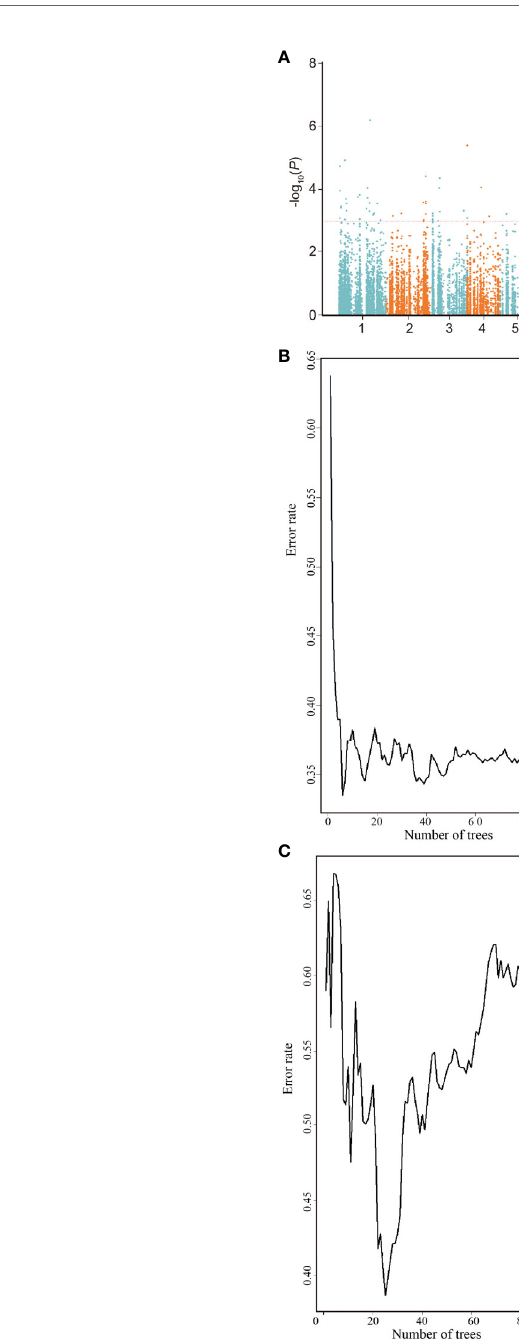
FIGURE 2 | Identi fi cation of an ATIRE prognostic signature for OS and DFS of BRCA patients. (A) Scatter plot of p -values in − log10 scale from the univariate Cox- PH model on associations between all ATIRE sites and OS of TCGA-BRCA patients. y-Axis refers to p -values in – log10 scale, and x-axis refers to chromosomal location of these ATIRE sites. (B) Random forest modeling (left) and analysis of variable importance of ATIRE sites (right) to OS of BRCA. Left: survival forest of 100 trees was created, using the log-rank splitting rule with ATIRE predictors randomly selected at each split. Right: survival random forest analysis furnishes a ranking of ATIRE predictors ’ importance in determining the accuracy of prediction. (C) Random forest modeling (left) and analysis of variable importance of ATIRE sites (right) to DFS of BRCA. Left: survival forest of 100 trees was created, using the log-rank splitting rule with ATIRE predictors randomly selected at each split. Right: survival random forest analysis furnishes a ranking of ATIRE predictors ’ importance in determining the accuracy of prediction. ATIRE, adenosine-to-inosine RNA editing; OS, overall survival; DFS, disease-free survival; BRCA, breast cancer; TCGA, The Cancer Genome